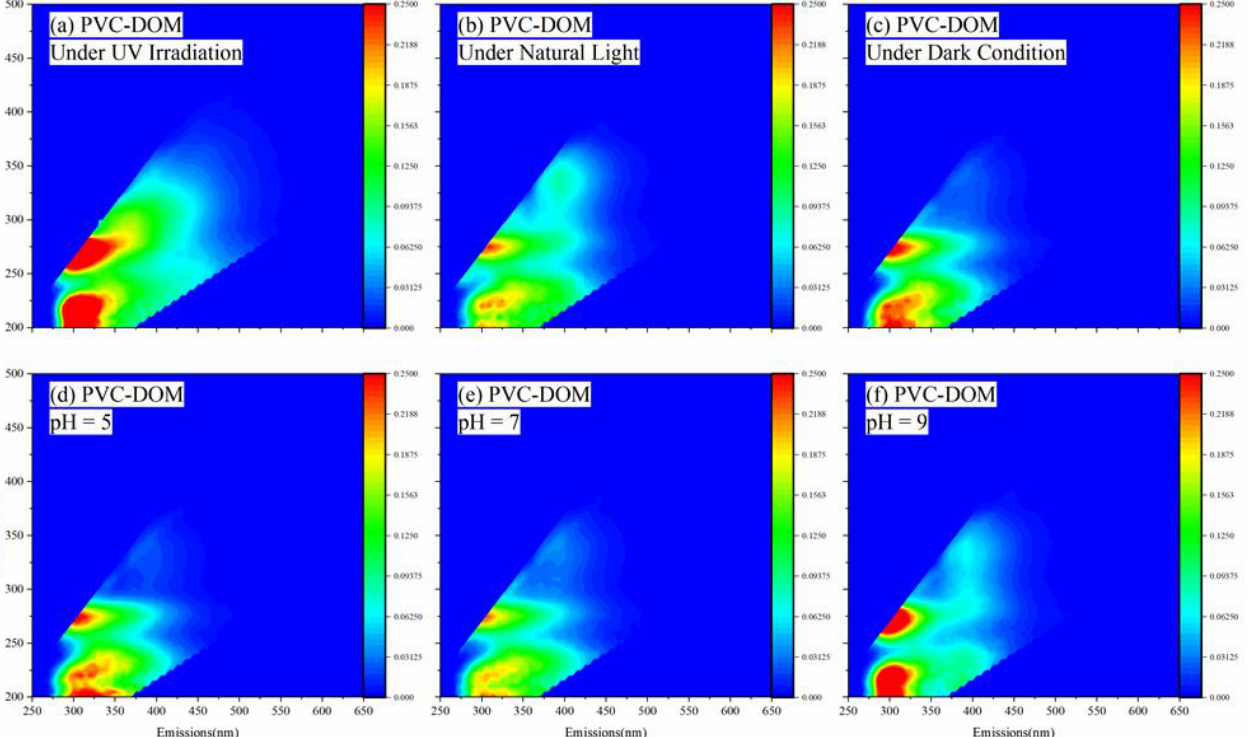
Figure 3. Fluorescence EEM plots of leached PVC-DOM under different light conditions: ( a ) UV irradiation; ( b ) natural light; ( c ) dark condition; and under different pH conditions: ( d ) pH = 5; ( e ) pH = 7; ( f ) pH = 9 after 7 days of leaching (5 g L −1 ).